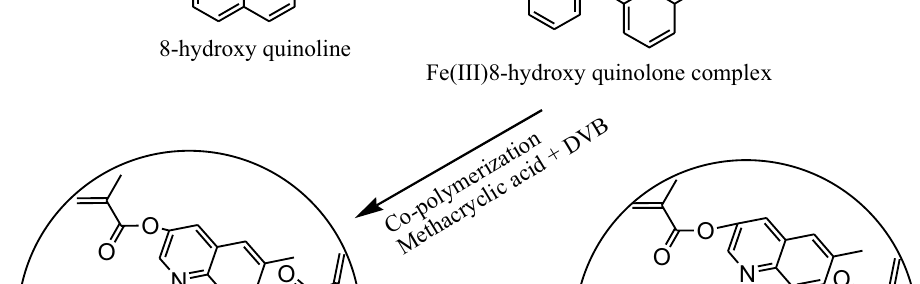
Fig. 1 Proposed reaction mechanism for the preparation of Fe(III)-IIP showing binding sites for Fe(III)